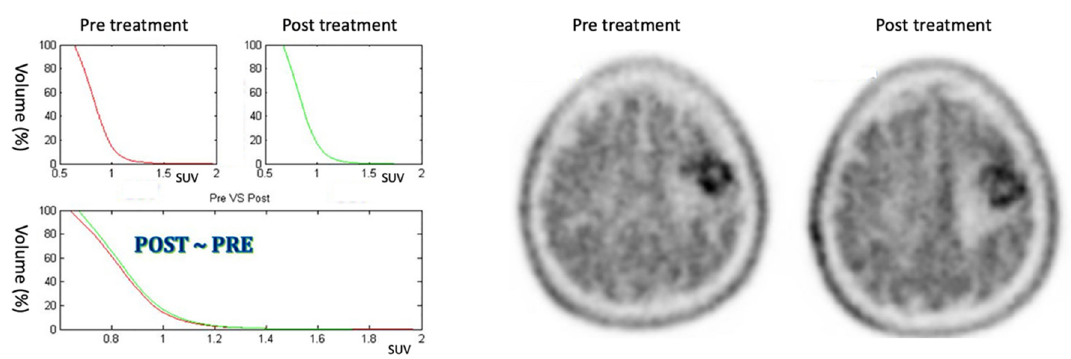
Figure 7. On the left: CSH pretreatment (top left); CSH post-treatment (top right); comparison between pre- and post-